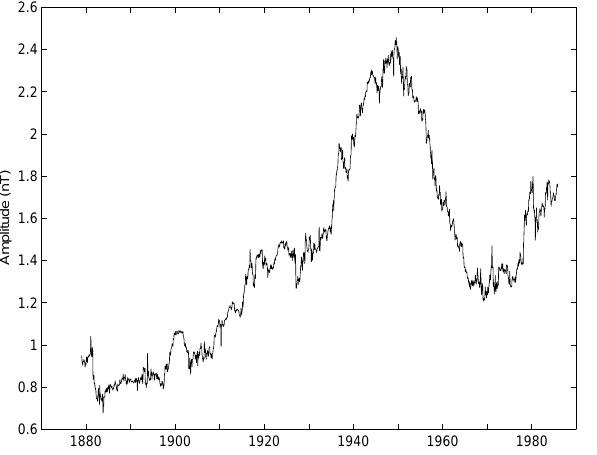
Fig. 2. Time variation of the amplitude of the aa -index semiannual variation, computed using a 22-year sliding window, centered.